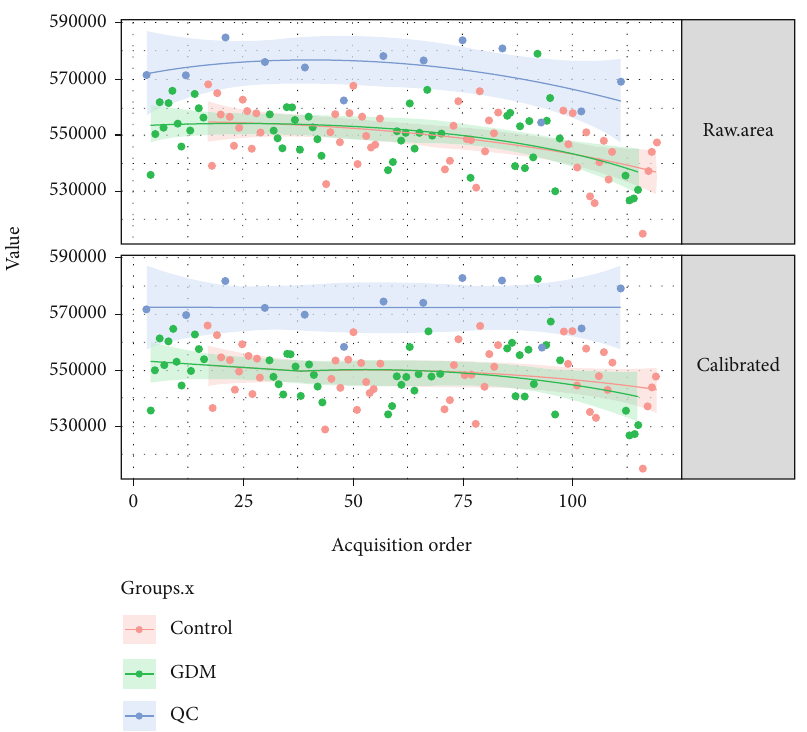
Figure 2: Intensity